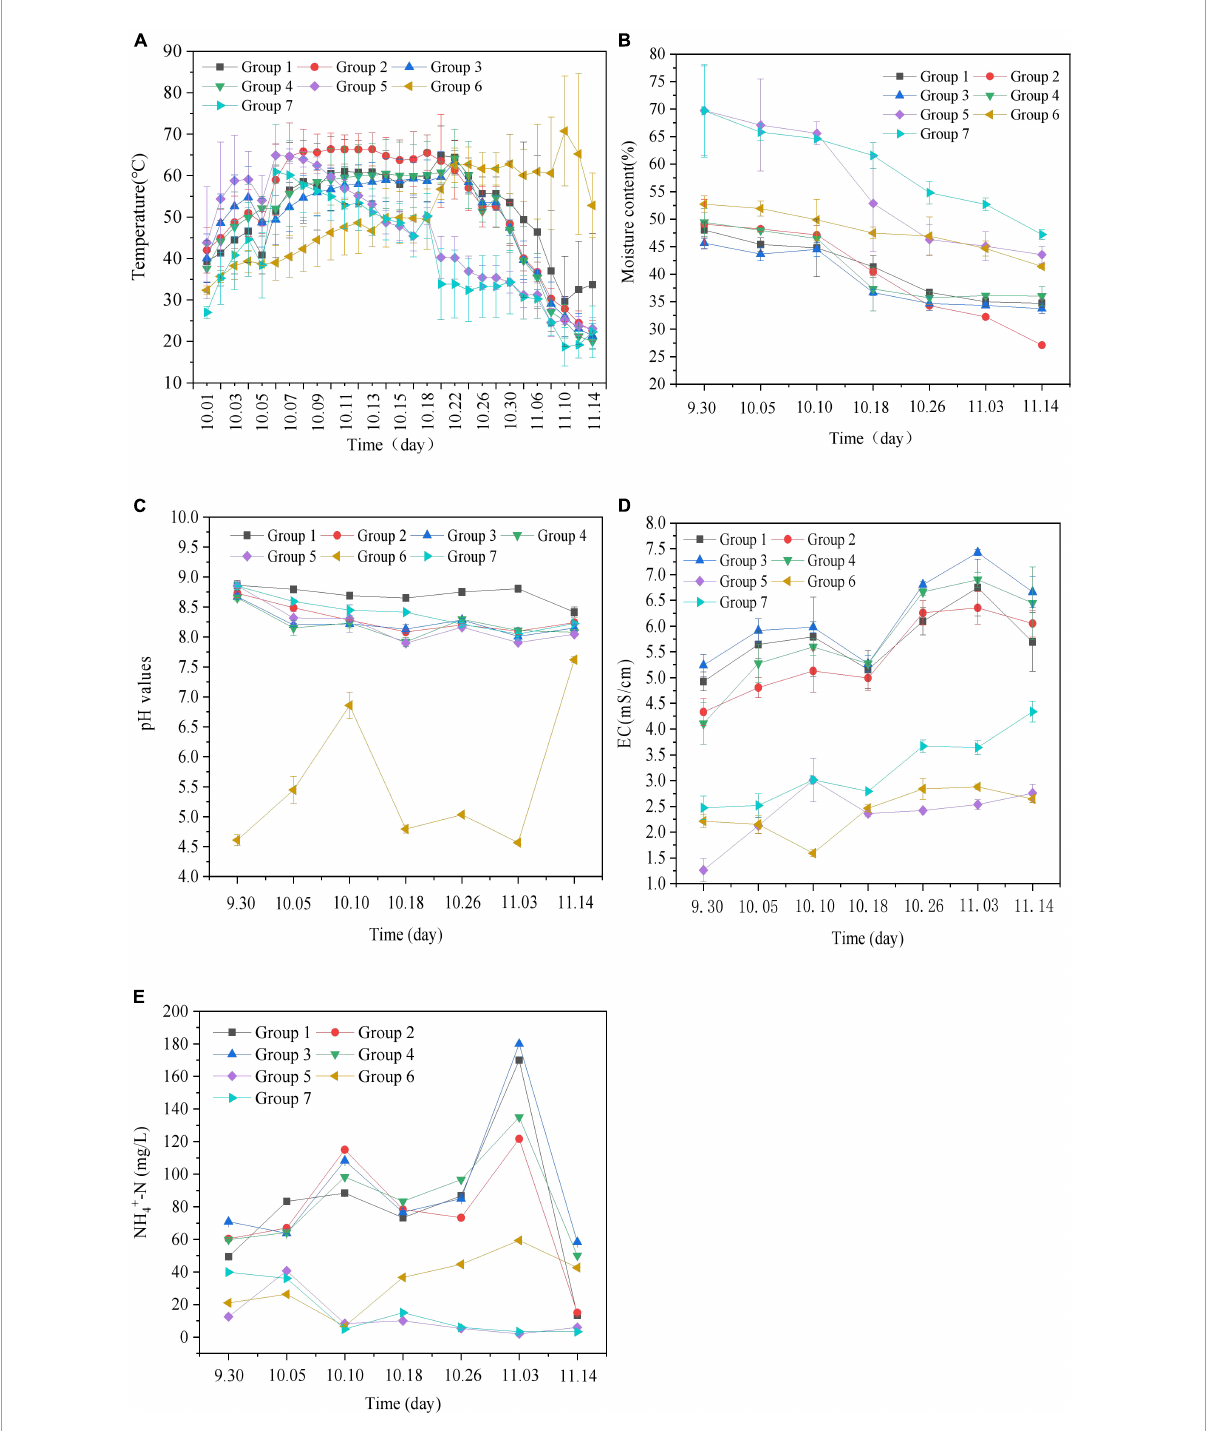
FIGURE1 Changes of physicochemical properties during the aerobic composting progress [ (A) temperature; (B) moisture content; (C) pH values; (D) electrical conductivity (EC) values; (E) NH 4 + -N values]. Group 1: cow manure + additives, contrast; Group 2: cow manure + additives + microbial inoculant; Group 3: cow manure + additives + microbial inoculant + calcium superphosphate; Group 4: cow manure + additives + microbial inoculant + calcium superphosphate + biochar; Group 5: cow manure + rice husk + microbial inoculant + calcium superphosphate + biochar; Group 6: cow manure + sugar residue + microbial inoculant + calcium superphosphate + biochar; Group 7: cow manure + tomato straw + microbial inoculant + calcium superphosphate +